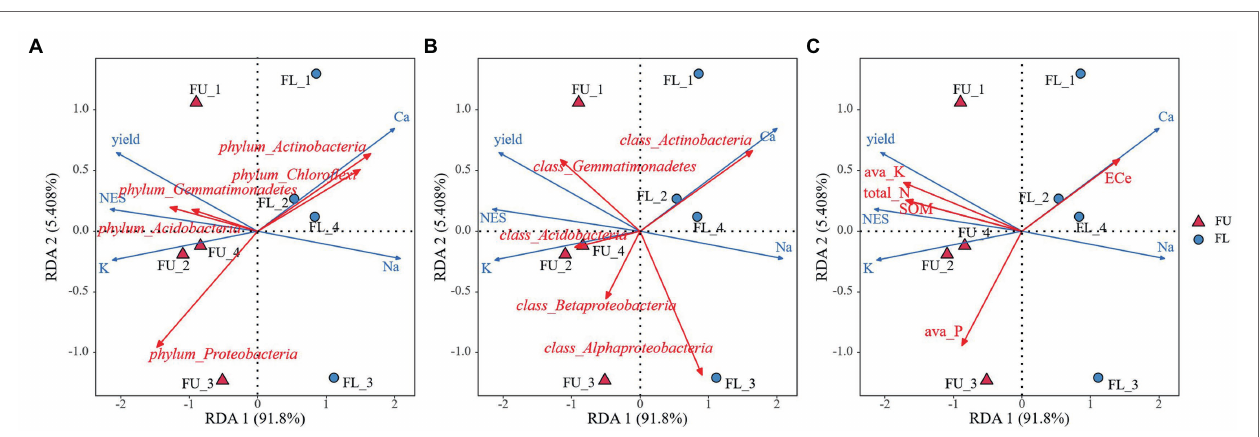
FIGURE 10 | Redundancy analysis (RDA) diagram illustrating the relationship between the plant characteristics between soil bacterial community composition at phylum-level (A) class-level (B) and soil properties (C) from two seeding